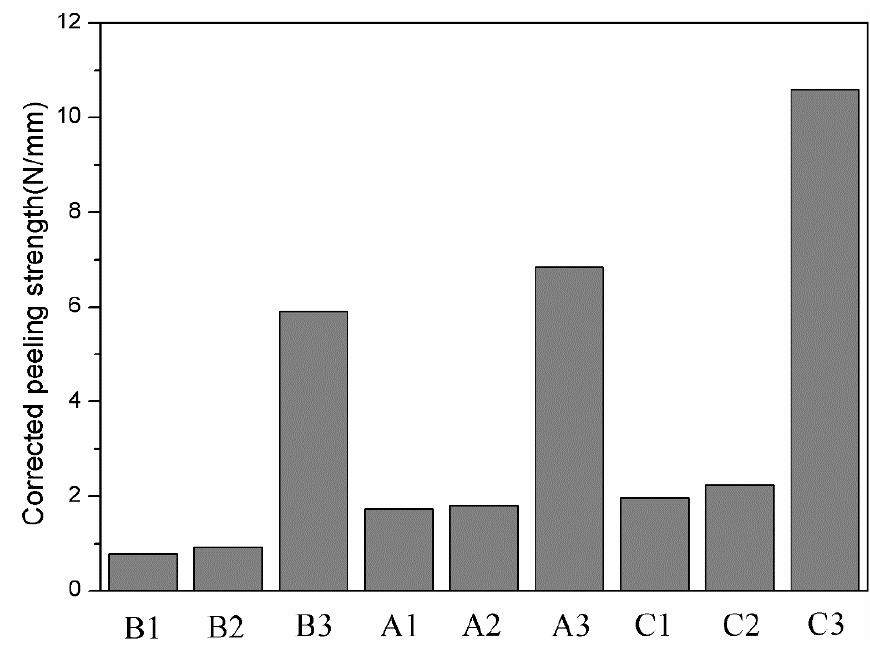
Figure 11. Area fraction of aluminium on the titanium side of the peeling surface of specimens A1, A2, A3, B1, B2, B3, C1, C2 and C3.